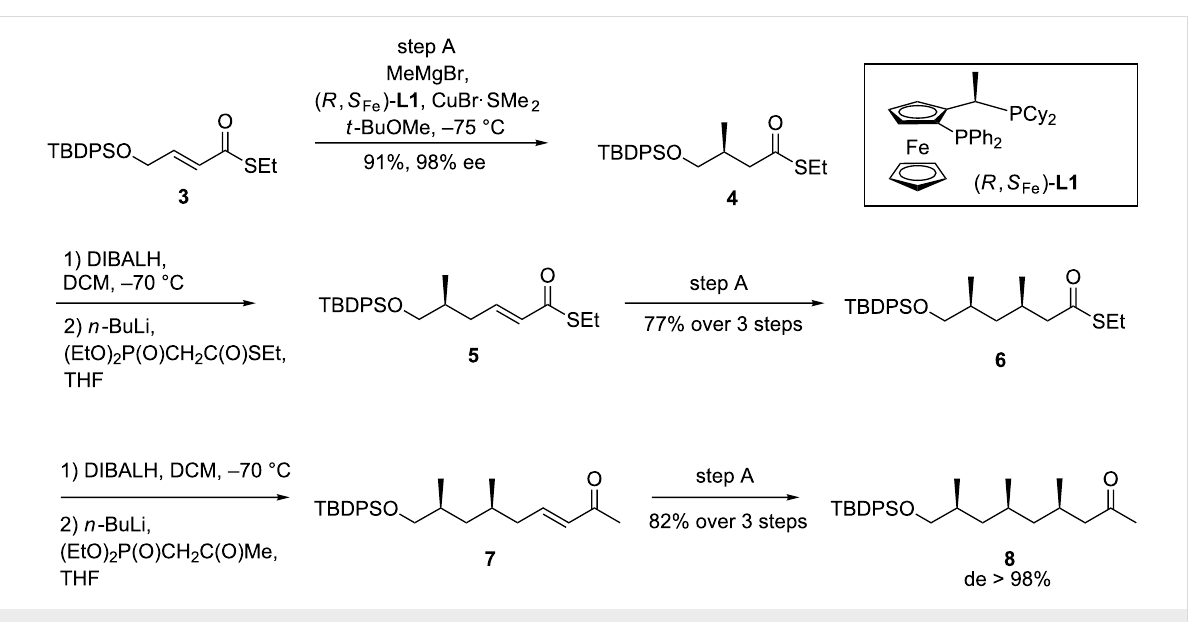
Scheme 1: Application of the iterative conjugate addition protocol for the preparation of 8